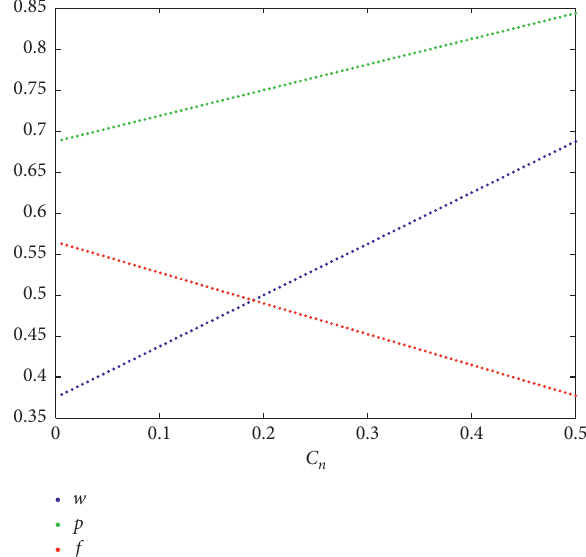
Figure 1: Optimal decision results when C